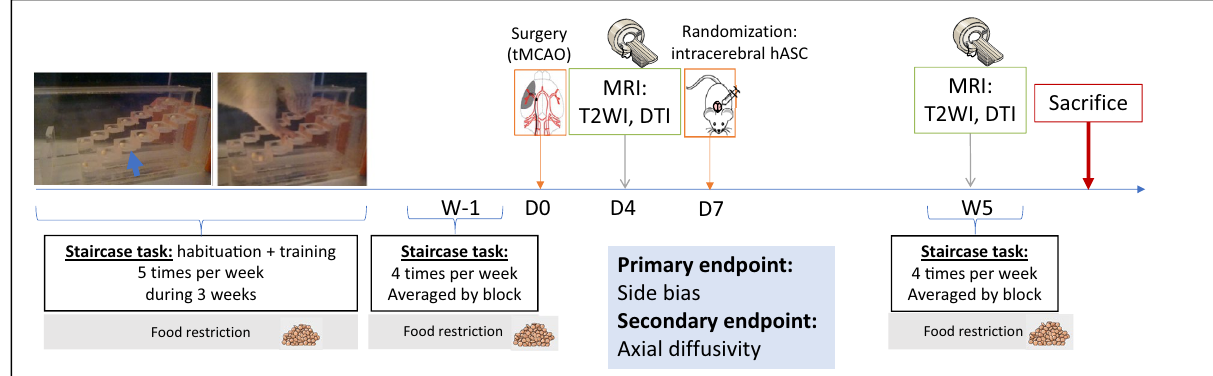
Figure 6. Design of preclinical therapeutic trial. The study design involves 2 staircase tasks (one before tMCAO surgery and one 5 weeks after, i.e. 4 weeks post-treatment) and 2 MRIs with T2-weighted imaging and DTI sequences (one at D4 post-surgery and one at 5 weeks after tMCAO surgery, i.e. 4 weeks